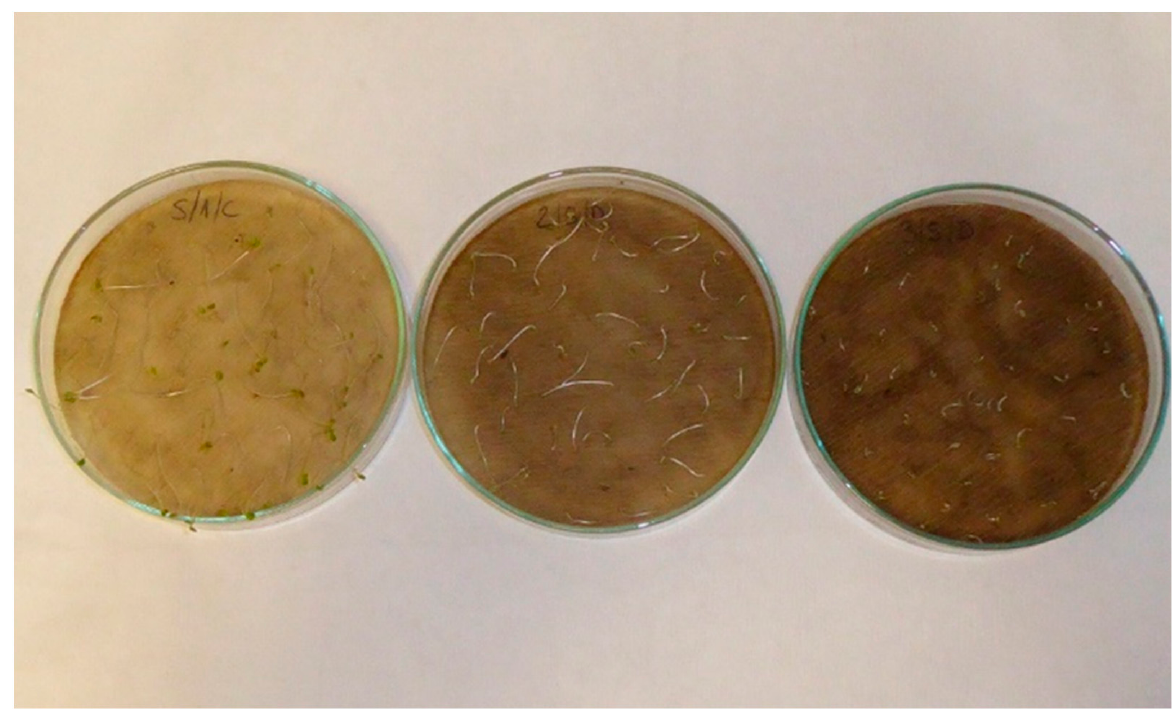
Figure A12. Lettuce ( Lactuca sativa L.) seedlings; treatments with aqueous extracts of nettle ( Urtica dioica L.) in 2.5% concentration ( left ), 5% concentration ( middle ) and 10% concentration ( right ).